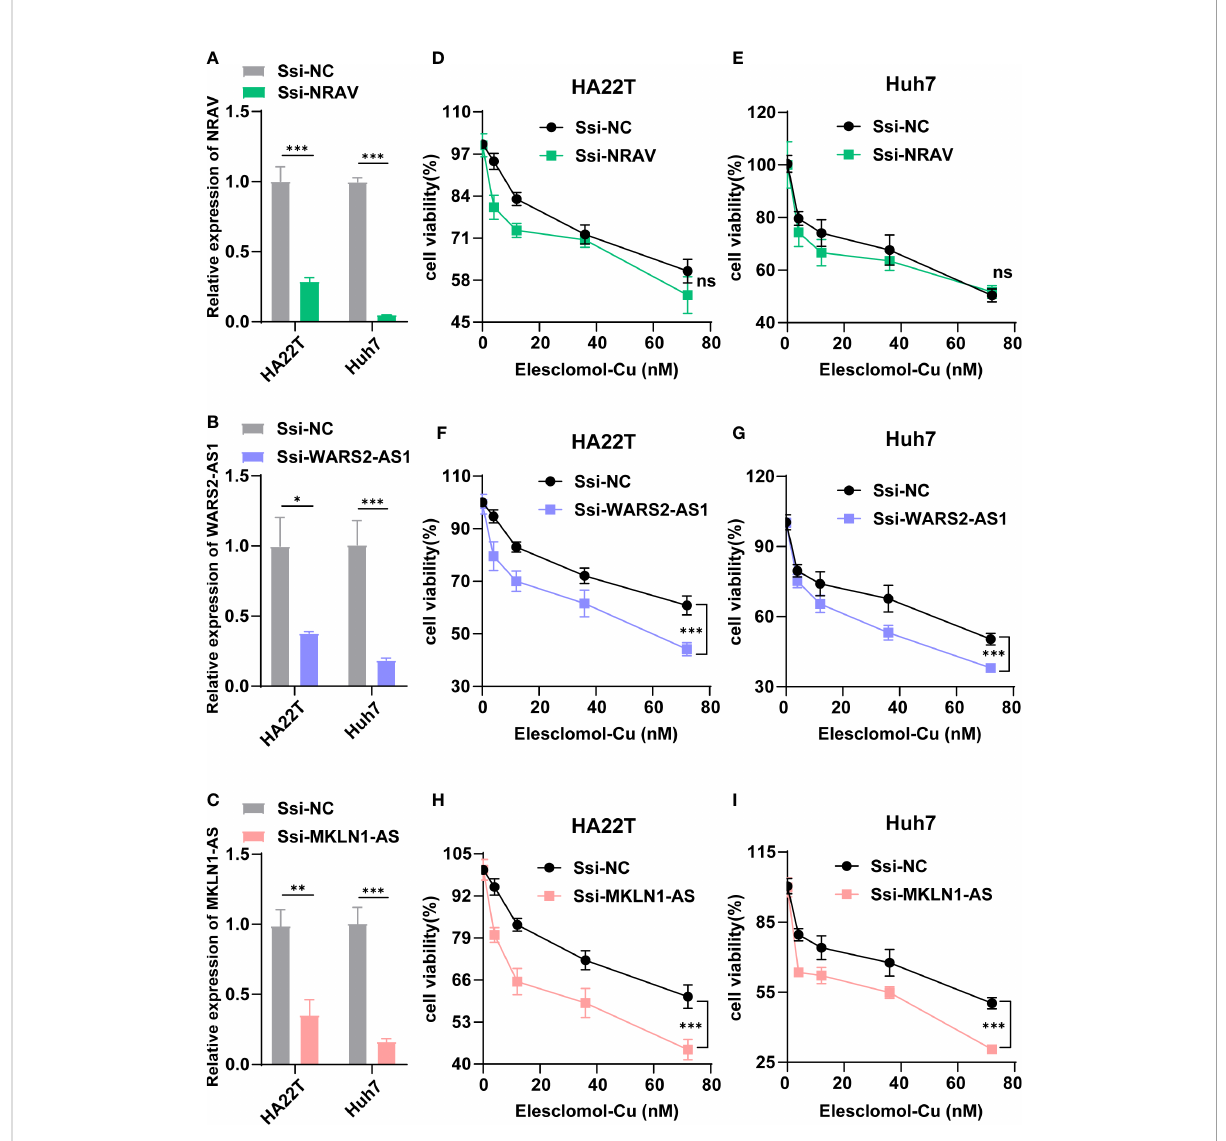
FIGURE 11 WARS2-AS1 and MKLN1-AS knockdown rendered cells susceptible for cuproptosis. (A-C) Relative NRAV, WARS2-AS1 and MKLN1-AS mRNA level in HCC cell with or without NRAV, WARS2-AS1 and MKLN1-AS knockdown (n=3). (D-I) HCC cells with or without NRAV, WARS2-AS1 and MKLN1-AS knockdown were exposed to different doses of elesclomol for 24h and detected by CCK8 reagent. SSi-NC, smart silencer negative control; *P < 0.05; **P < 0.01; ***P < 0.001; ns, no signi fi